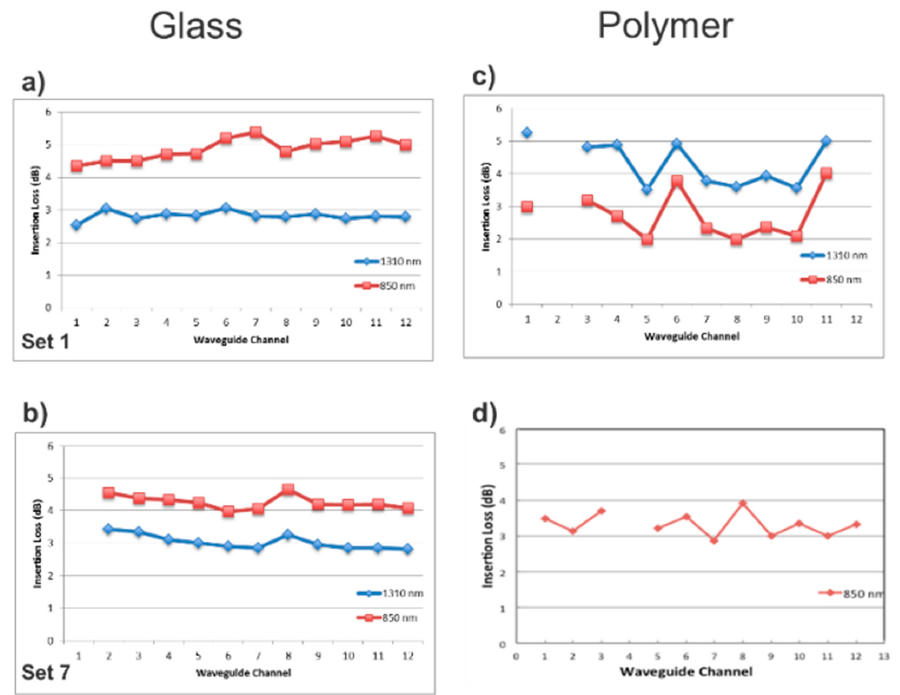
Figure 12. Insertion loss measurements at 850 nm and 1310 nm on glass and polymer waveguide samples, ( a ) Fraunhofer IZM glass waveguide sample set 1, ( b ) Fraunhofer IZM glass